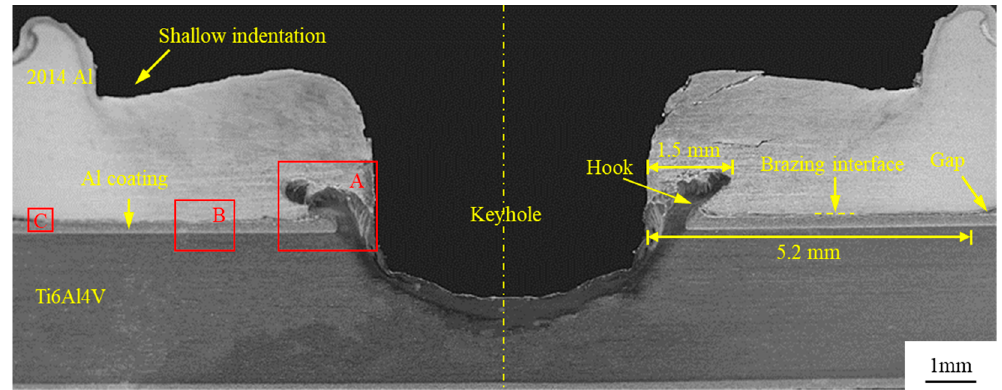
Figure 3. Typical cross-sectional of the FSSW-B joint made at the rotation speed of 1200 rpm. The labeled dimensions were measured via the optical microscope measurement.